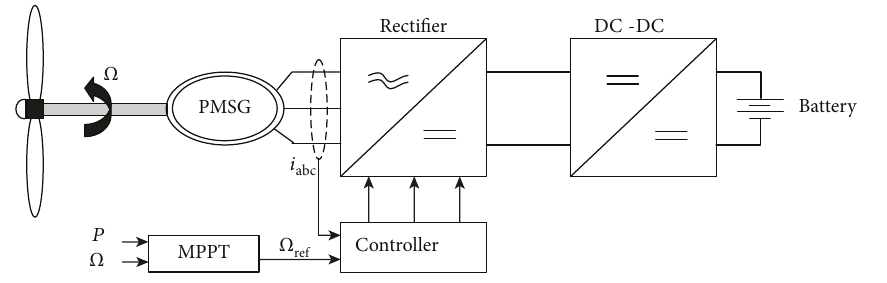
Figure 4: Schematic of a wind energy system.